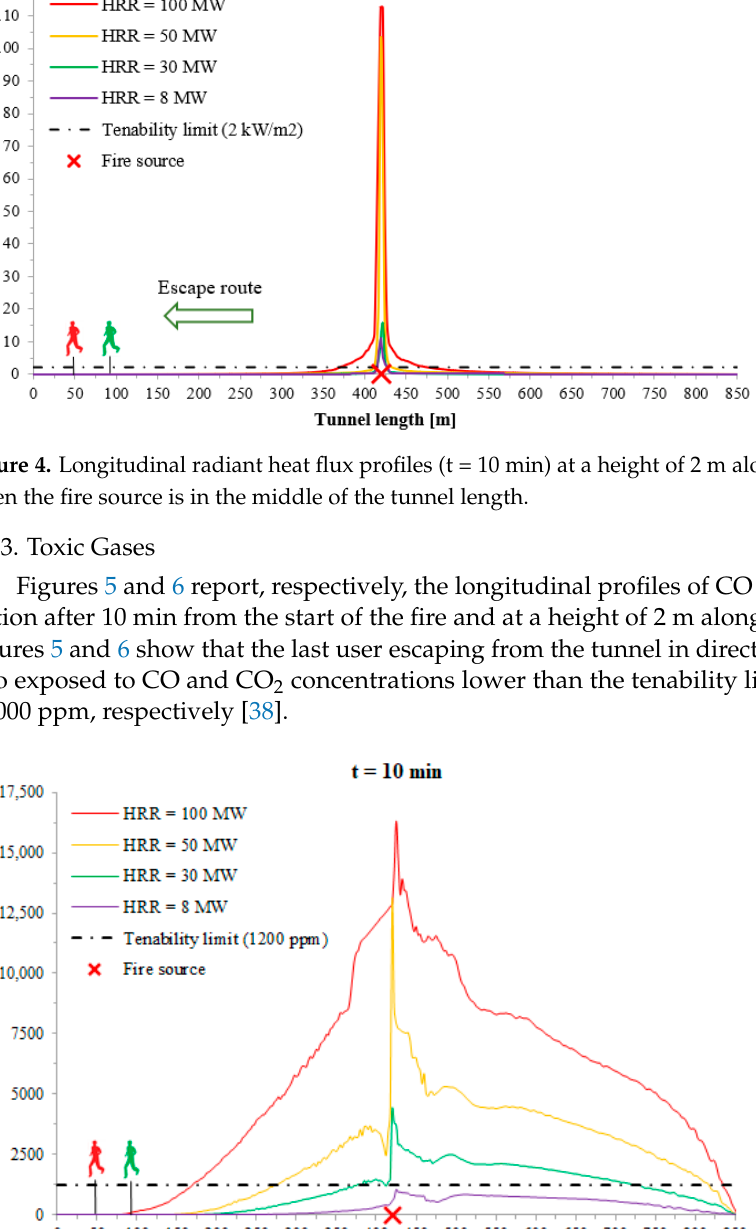
Figure 3. Longitudinal temperature profiles (t = 10 min) at a height of 2 m along the escape path when the fire source is in the middle of the tunnel length.